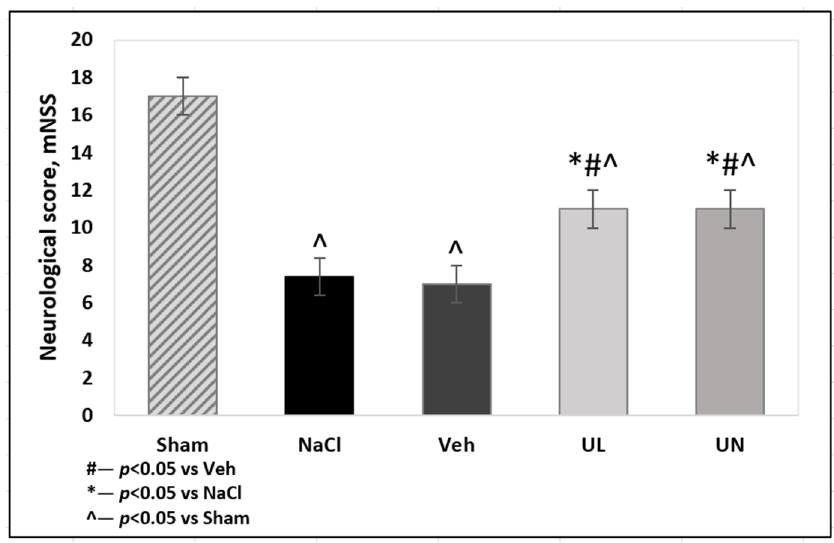
Figure 1. Neurological score, measured by mNSS scale 24 h after middle cerebral artery occlusion. Groups: Veh–MCAO + Vehicle; NaCL–MCAO + NaCL; UL–MCAO + Ubiquinol; UN–MCAO + Ubiquinone; Sham-operated.